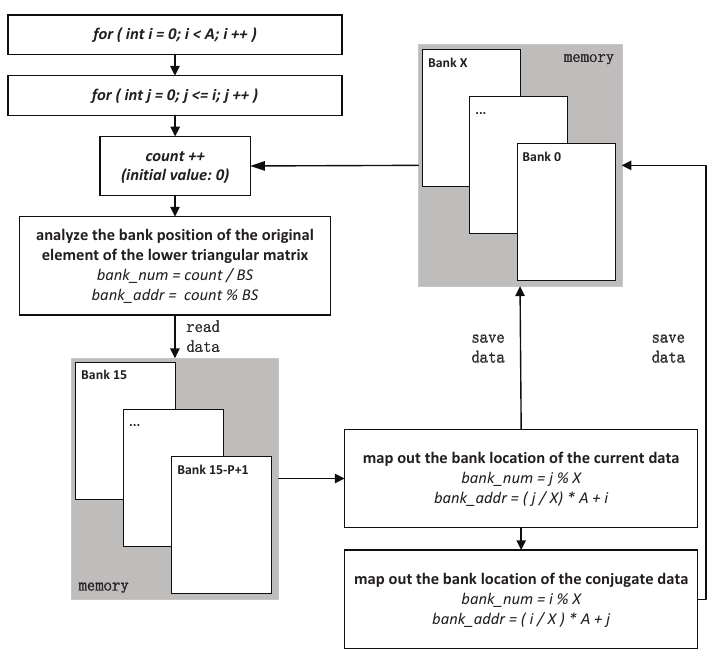
Figure 5. Address mapping mechanism of the conjugate symmetry of lower triangular